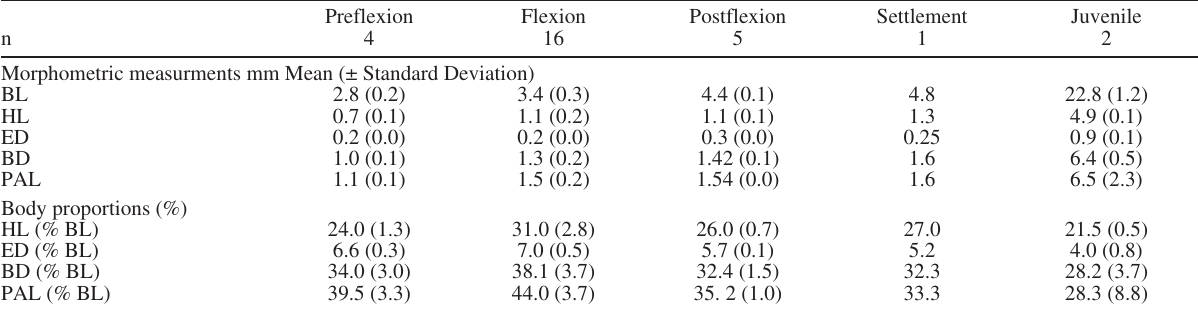
Table 1. – Morphometric measurements and body proportions for larval developmental stages of Solea turbynei (HL, head length; ED, eye diameter; BD, body depth; PAL, pre-anal length) relative to body length (BL).